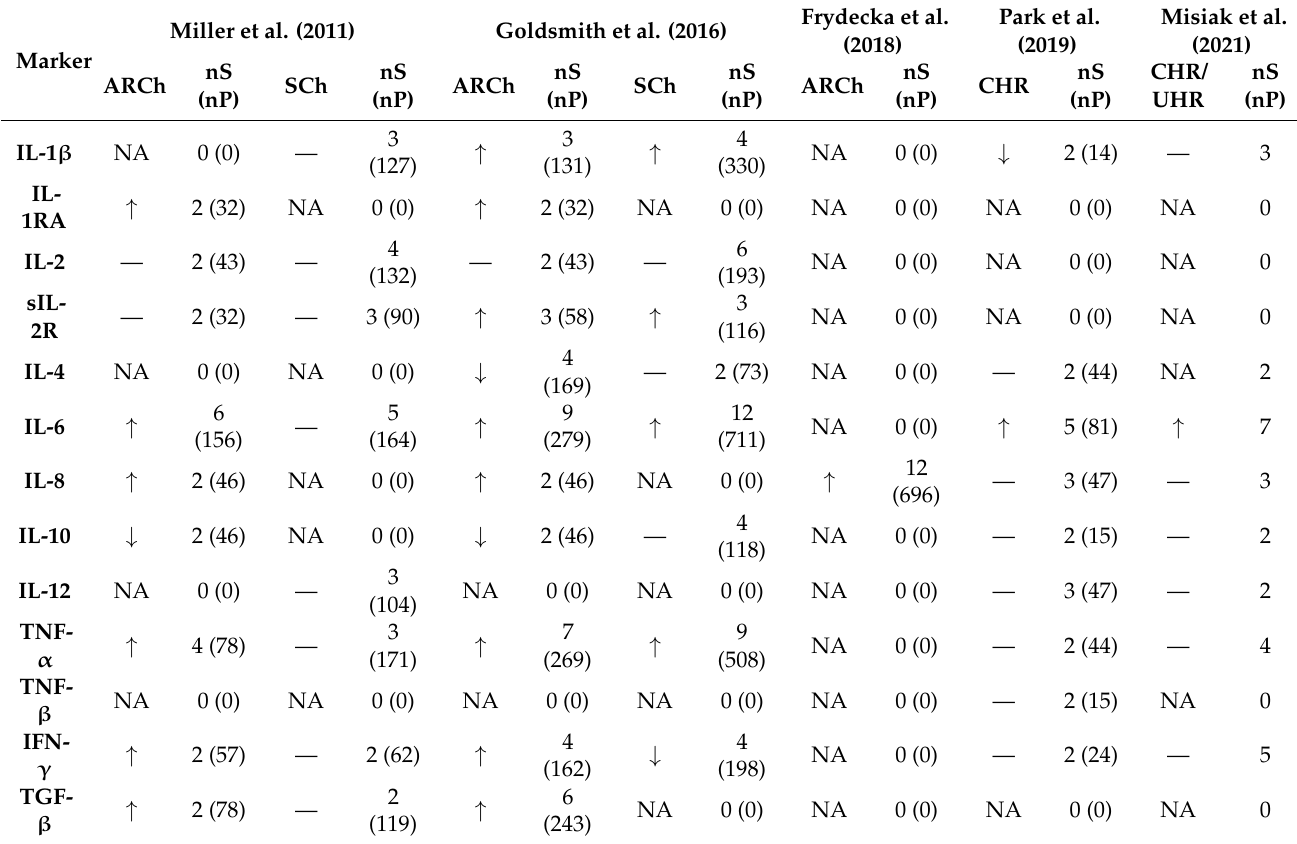
Table 2. Summary of meta-analytical data concerning peripheral cytokine levels in acute relapsed chronic (ARCh), stable chronic (SCh) and clinical high-risk or ultra-high-risk (CHR/UHR) patients as compared to healthy controls. Miller et al. (2011) Marker